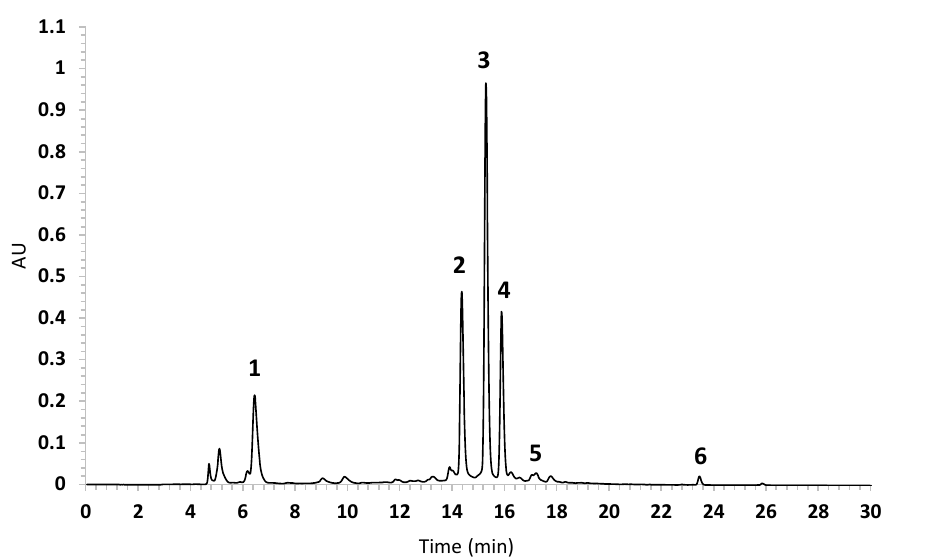
Figure 4. HPLC-PDA chromatogram of B. heterophylla aqueous extract under optimized conditions; detection wavelength at 327 nm. Peak identification: 1 : R T 6 min; 2 : R T 14.6 min; 3 : R T 15.6 min; 4 : R T 16.2 min; 5 : R T 17.2 min; 6 : R T 23.6 min. Table 2. Parameters of validation of method for determination of constituents in B. heterophylla . Linear Range N ◦